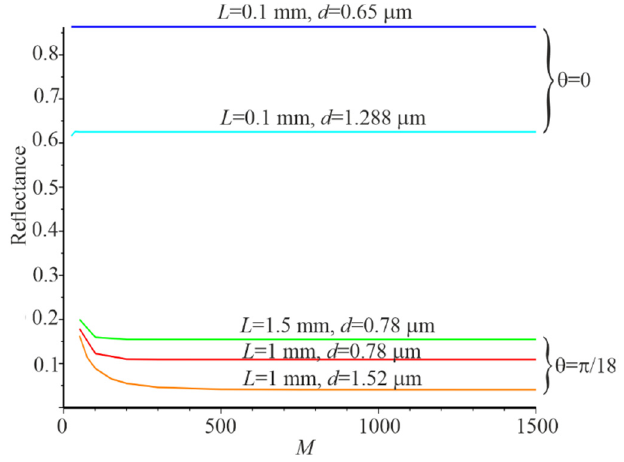
Figure 3. Dependences P r of the plane waves used in the Gaussian beam expansion under different resonance conditions.